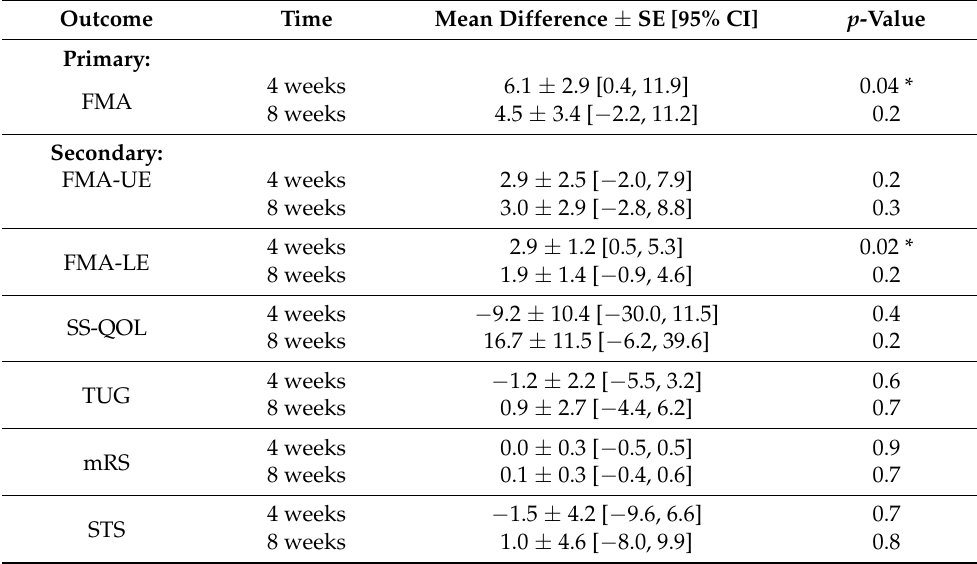
Table 2. Difference between groups in the primary and secondary outcome measures.